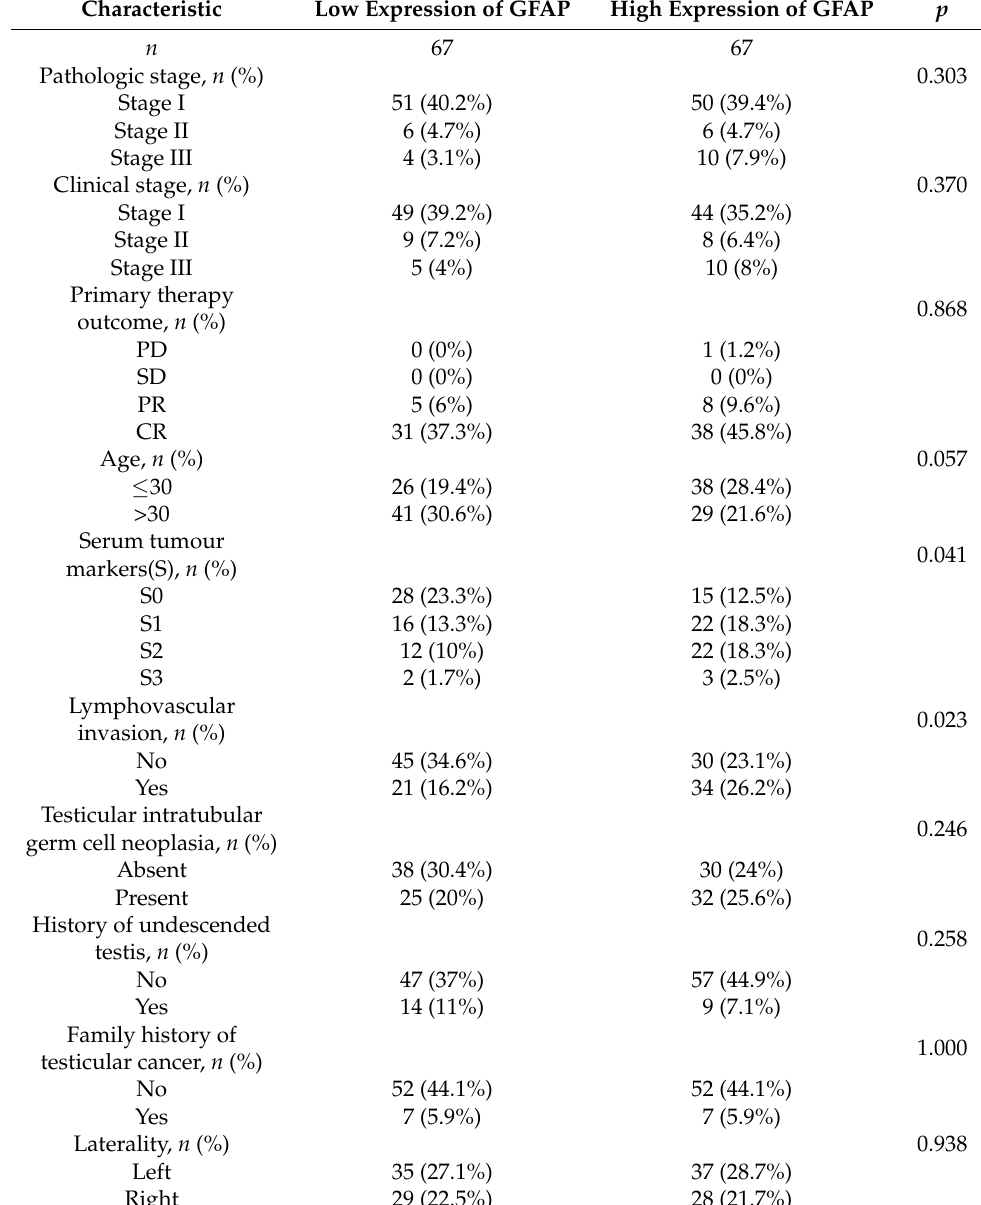
Table 2. Baseline information sheet for GFAP, assessing the difference in the composition ratios of the high and low GFAP mRNA expression subgroups in the different TGCT clinical variables. Characteristic Low Expression of GFAP High Expression of GFAP p n 67 67 Pathologic stage, n (%)